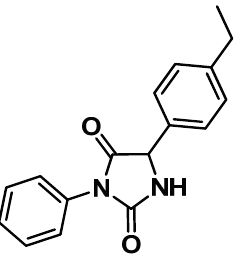
Figure 6. Chemical structure of hydantoin derivative IM-3 (3-phenyl-5-(4-ethylphenyl)-